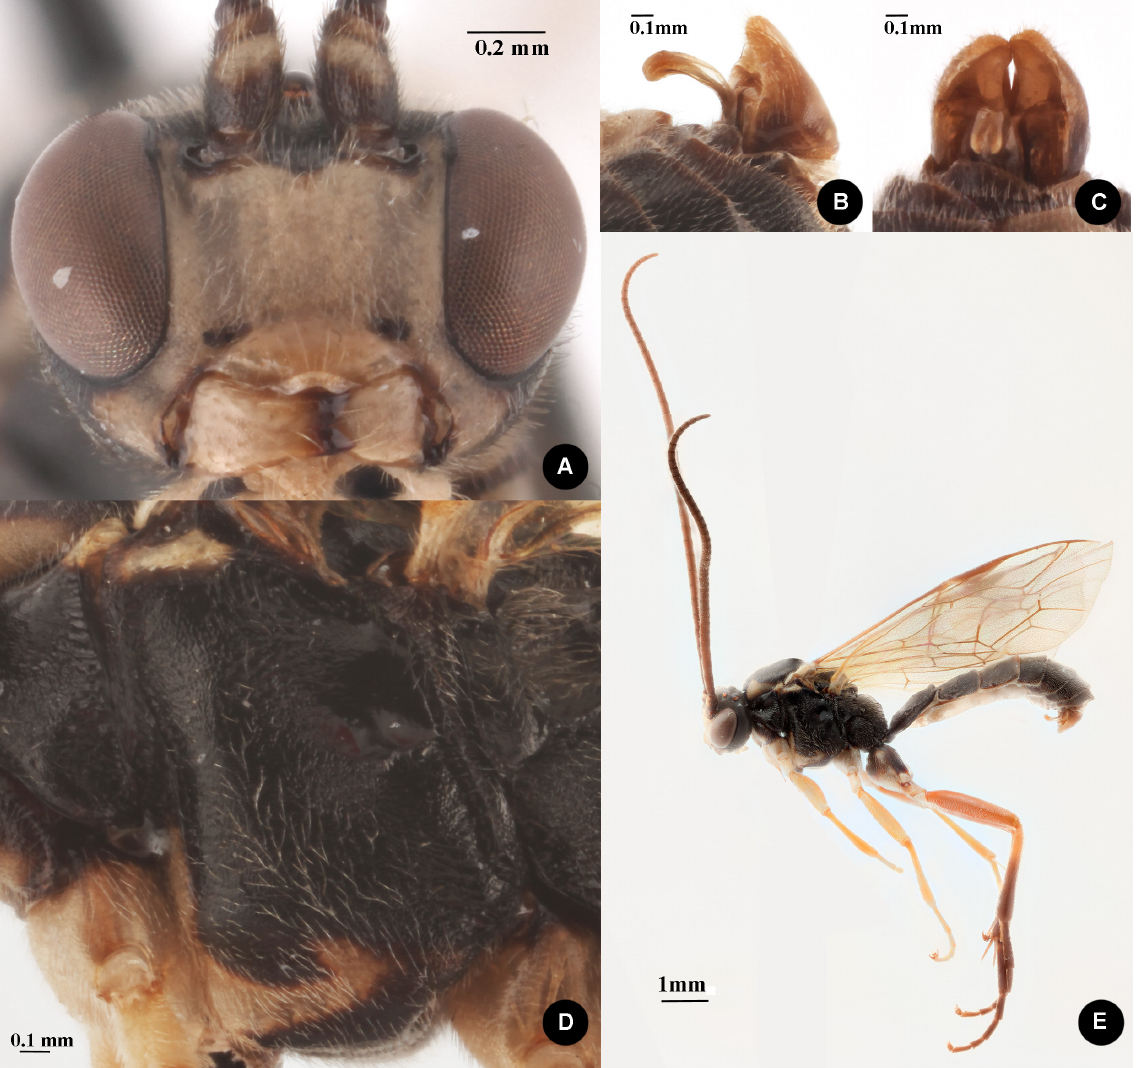
Fig. 4. Rhinotorus campester sp. nov., holotype, ♂. A . Face. B . Male genitalia laterally. C . Male genitalia ventrally. D . Mesopleuron. E .